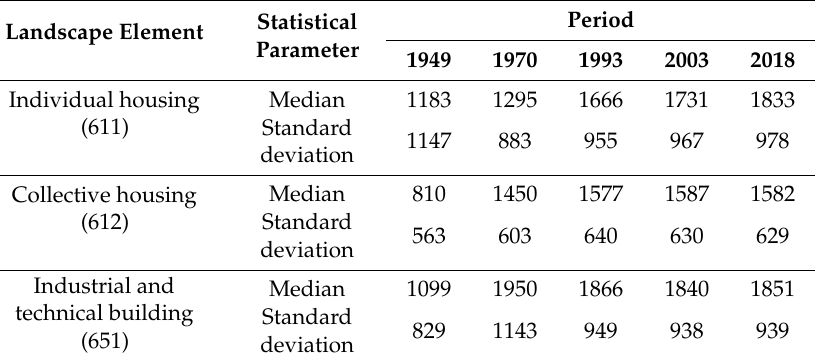
Table 9. Statistical analysis of the accessibility of selected landscape elements from railroad stations (in